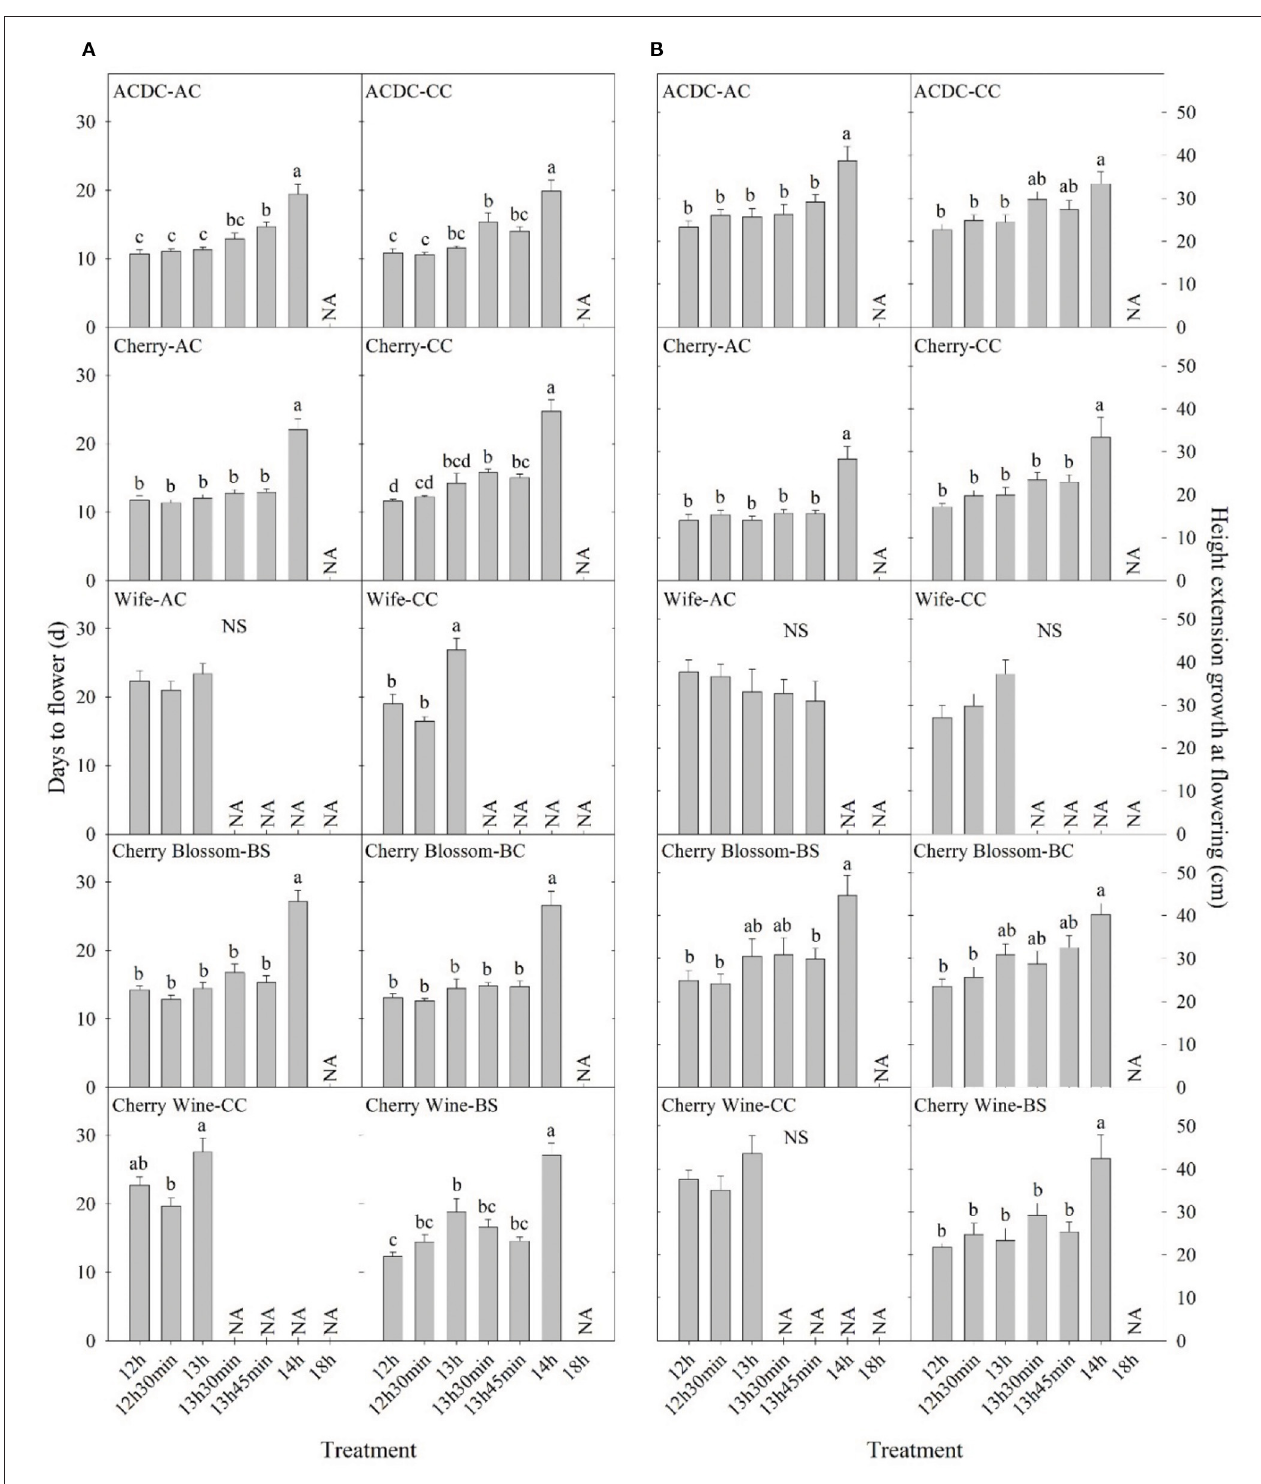
FIGURE 3 | Comparison of (A) days to flower and (B) height extension growth at flowering of 10 essential oil cultivars with the same name but different sources in Expt. 1. All data were pooled from 10 replications except “ACDC-AC” ( n = 9). NS indicates insignificant treatment effects. NA indicates less than four valid data under such treatment. Means sharing a letter are not statistically different by Tukey’s honest significance difference test at P ≤ 0.05. Error bars indicate standard error.